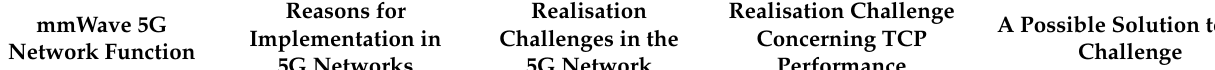
Table 3. Challenges and possible solutions to the realisation of TCP CC with respect to 5G main mmWave network functions. mmWave 5G Network